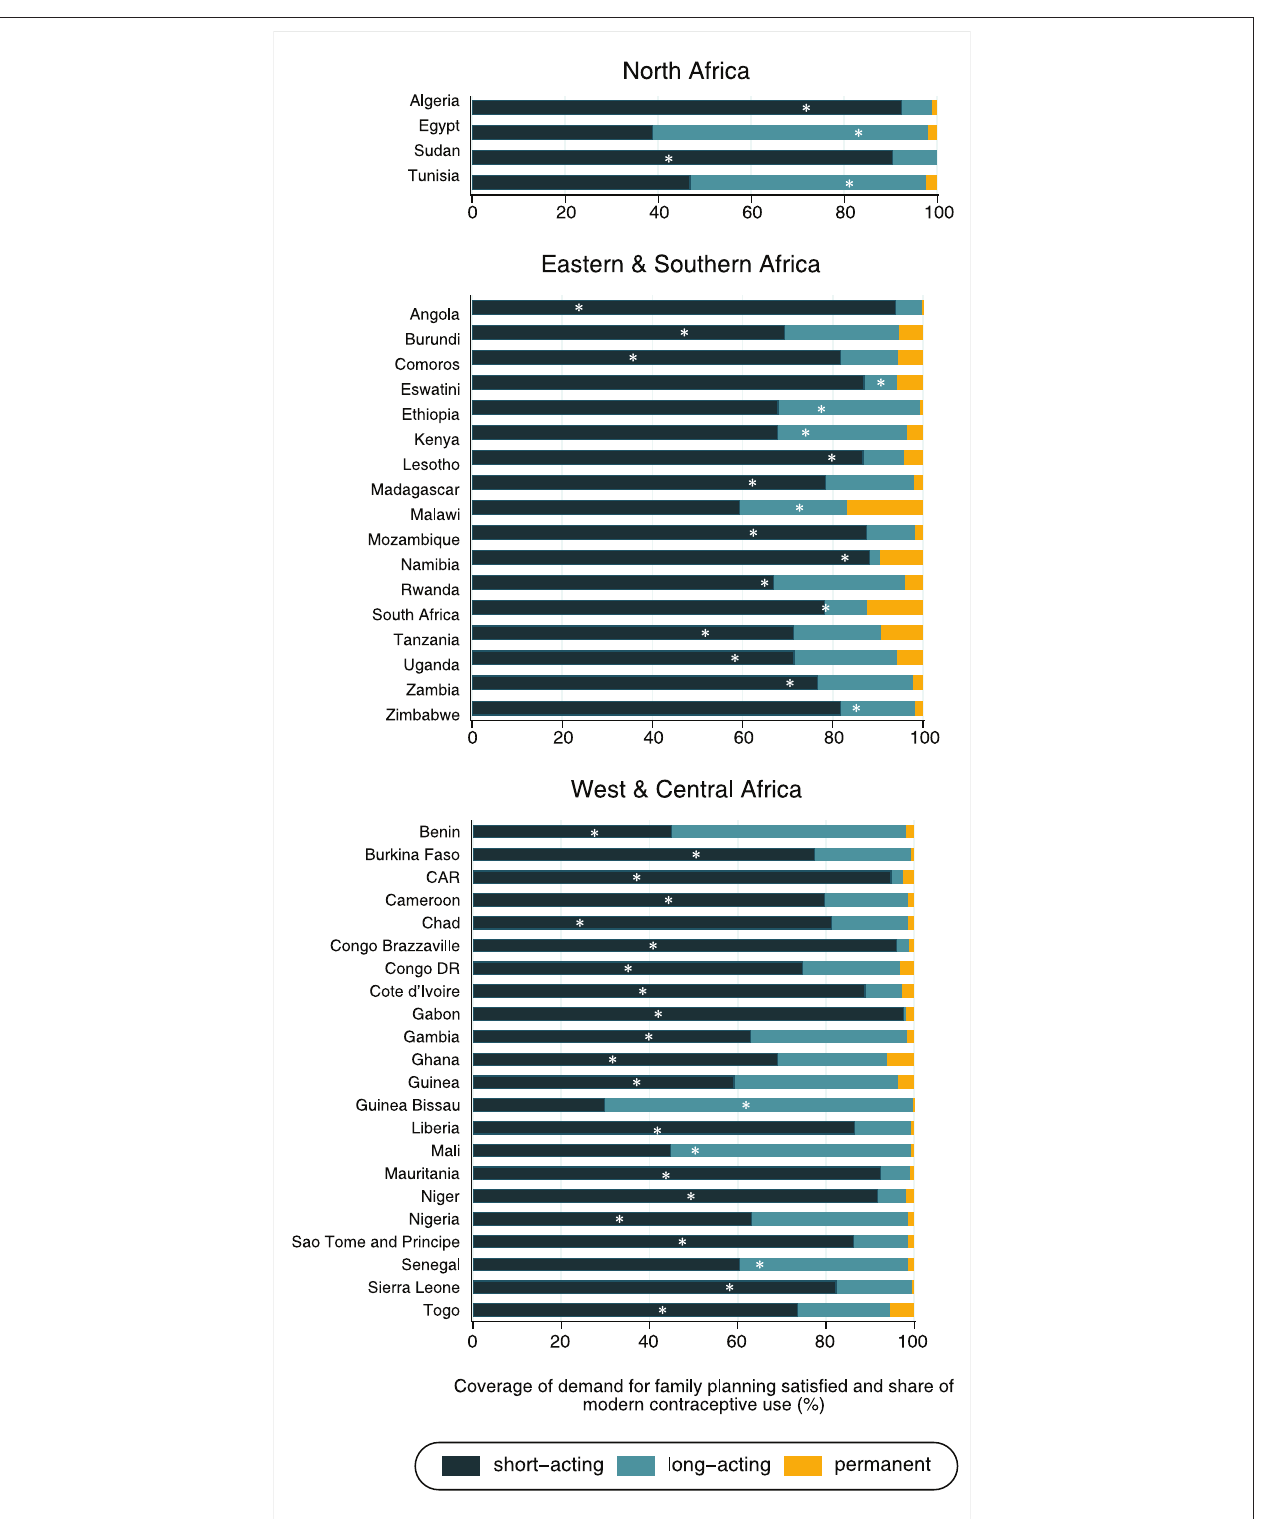
FIGURE 1 | Share of modern contraceptive use and coverage of demand for family planning satisfied by modern methods (white dot meaning of “*”) according to world region.